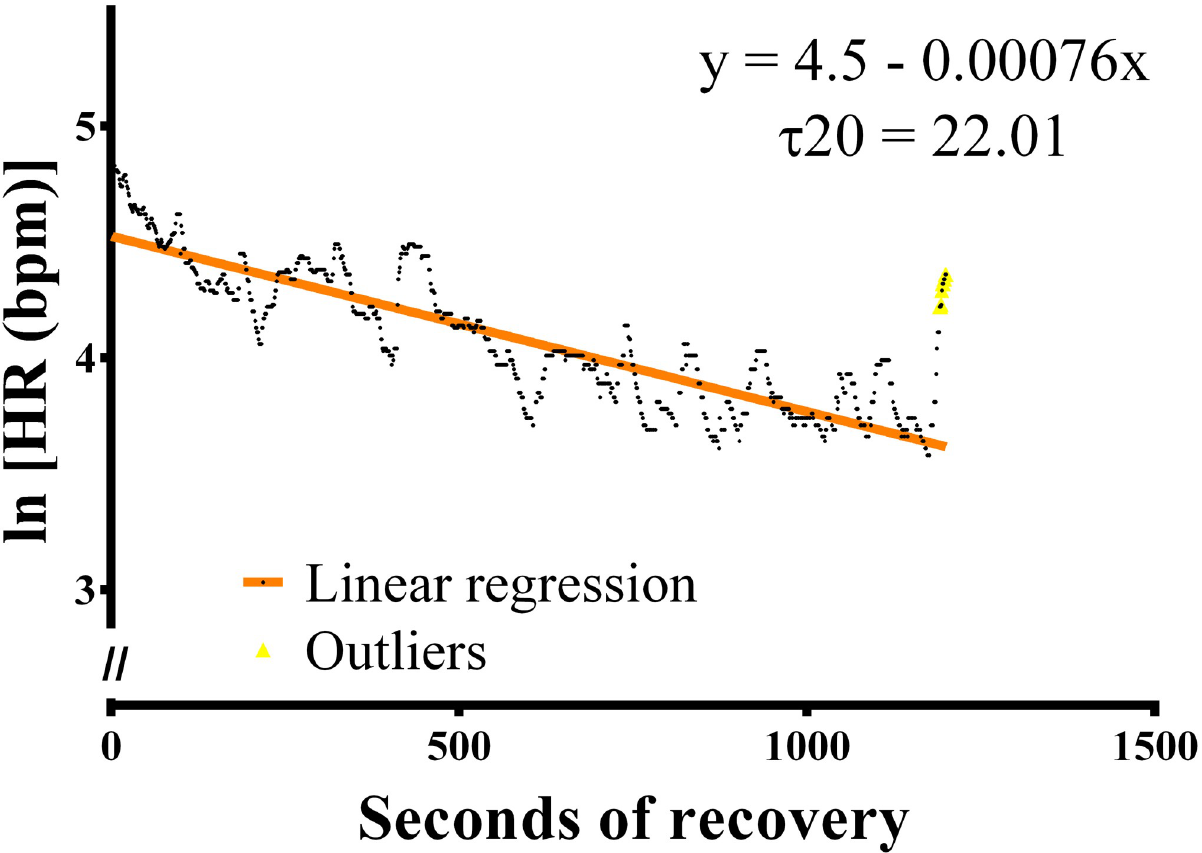
Fig 3. Single dog’s time constants of the post-exercise HR decay ( τ 20; Dog n˚ 7). The τ 20 was determined starting from the slope of the regression line obtained by plotting the natural logarithm of the heart rate (HR) vs time (during the first 20 min of recovery).